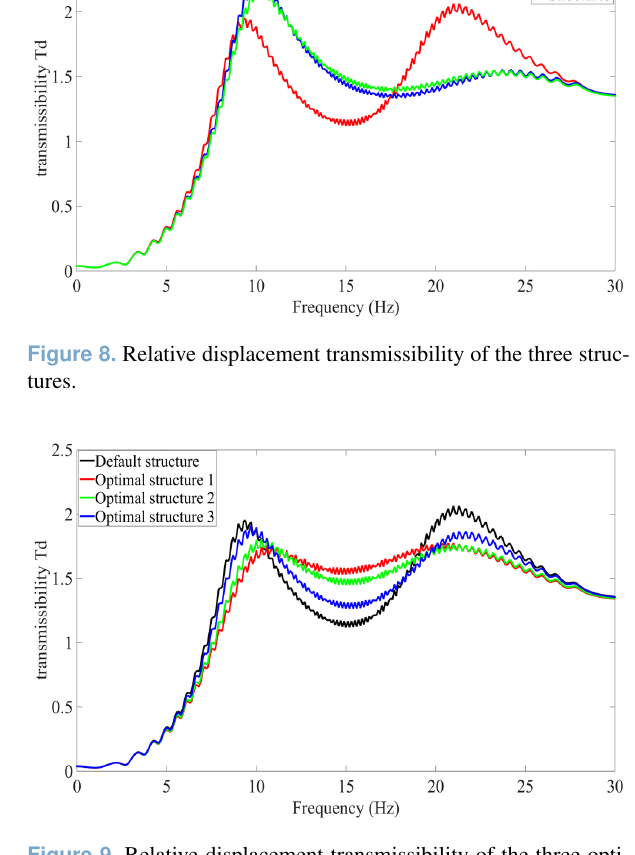
Figure 9. Relative displacement transmissibility of the three opti- mized structures and the conventional channel